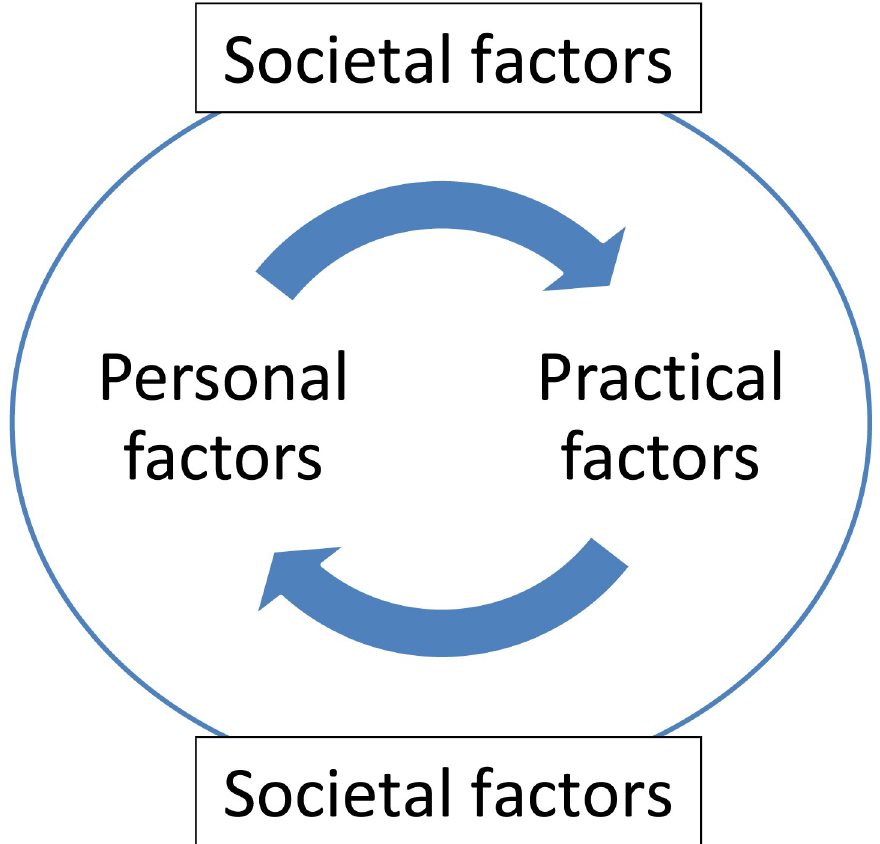
Fig 2. The holistic model of welfare stress and